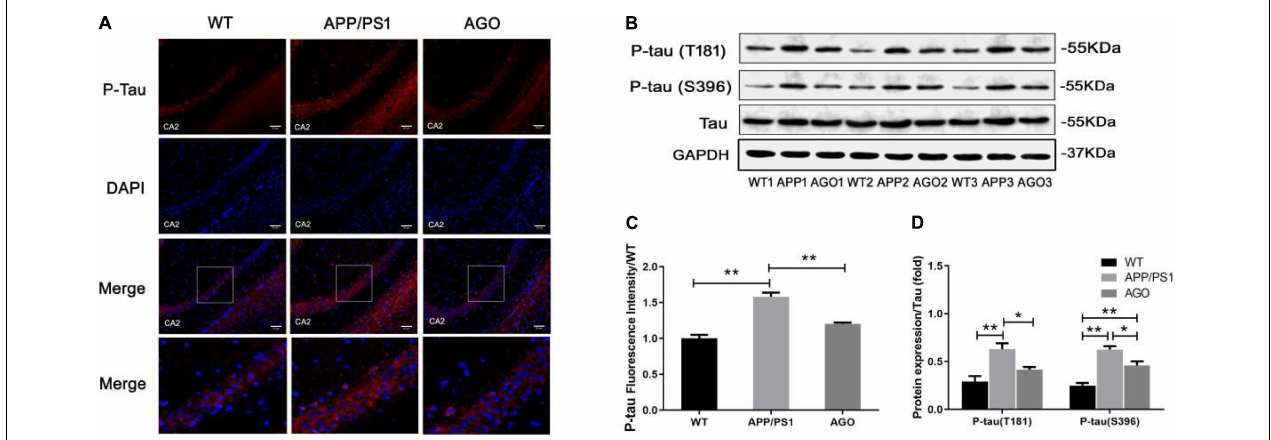
FIGURE 3 | Effect of agomelatine on tau protein hyperphosphorylation in APP/PS1 mice. In the agomelatine-treated group, mice were intraperitoneally injected with agomelatine (50 mg/kg/day) for 30 days. (A,C) Measurement of P-tau (T181) by immunofluorescence (200 × , scale bars = 50 µ m) ( n = 3). (B,D) Measurement of P-tau (T181) and P-tau (S396) by Western blot ( n = 5). Values are represented as the mean ± SEM. * P < 0.05; ** P < 0.01.